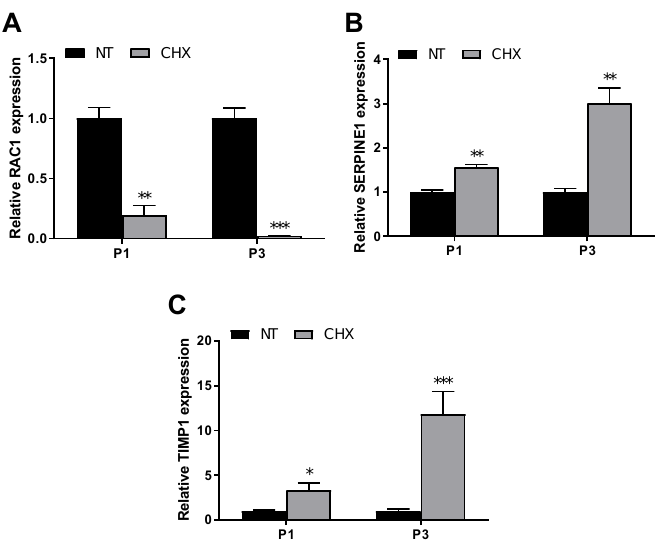
Figure 3. CHX modulates mRNA expression of genes involved in early wound healing. Quantitative real-time PCR analysis of RAC1 ( A ), SERPINE1 ( B ) and TIMP1 ( C ) mRNA expression in NT and CHX biopsies of two patients. Relative mRNA levels are shown as fold value of the NT levels. mRNA levels were normalized to GAPDH mRNA expression. Each experiment was performed in triplicate. Error bars represent standard deviations. * p < 0.05, ** p < 0.005, and *** p < 0.0005 vs. NT.